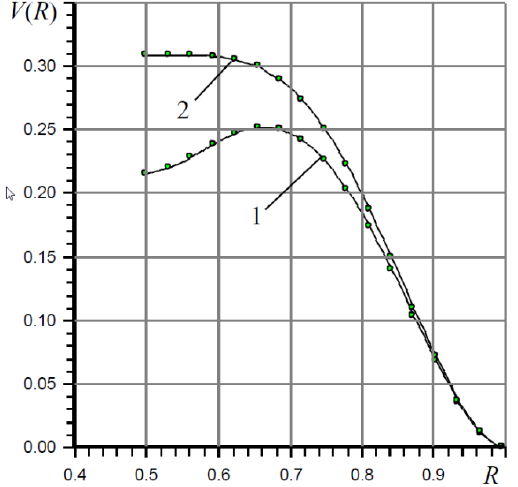
Figure 2. Curves of the deflection function at edge (1) and ring (2) contacts of the membrane with the disc, R 1 = 0.5 The minimum radius R of the membraneto Disk 2 x